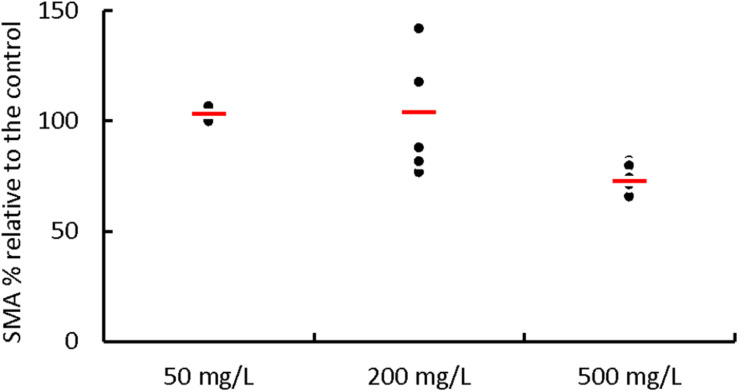
Effect of the phenol addition on the percentage of the acetoclastic SMA of the AnMBR sludge. Each point represents the percentage of the SMA value when phenol, at different concentrations, was added in comparison to the value of the control SMA (acetate at 2 g COD⋅L–1). The thick red line represents the average SMA value for the different phenol concentrations.